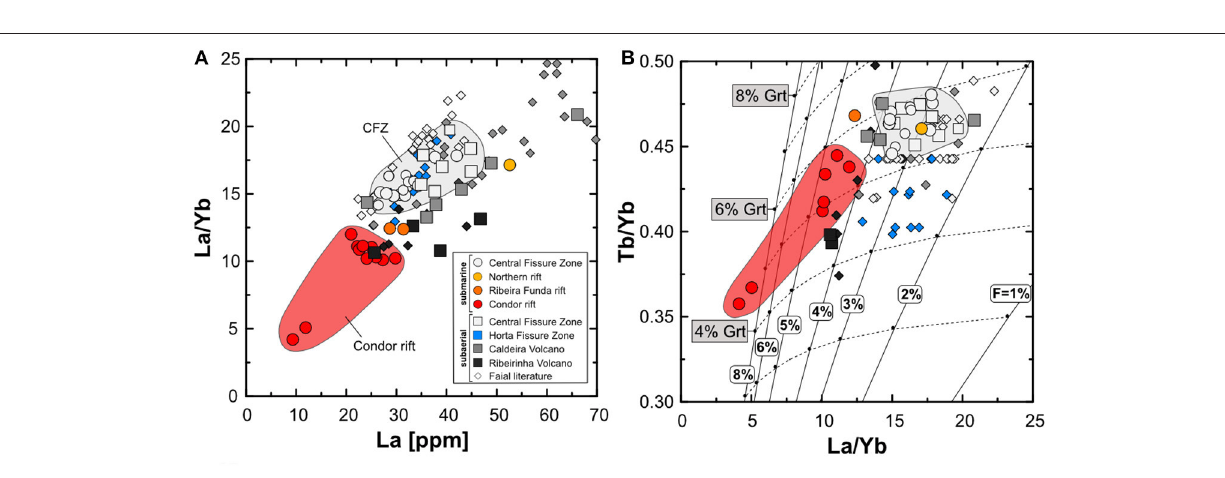
FIGURE 9 | La/Yb vs. (A) elemental concentration of La [ppm] and; (B) Fractional melting model modified from Bourdon et al. (2005) and Beier et al. (2013) for Faial lavas using a Tb/Yb vs. La/Yb space and a primitive mantle source from Sun and McDonough (1989) comprised of 55% olivine, 25% orthopyroxene and variable ratios of clinopyroxene and garnet as shown by gray boxes and dashed lines, respectively. White boxes and solid lines mark the degree of partial melting. Partition coefficients for olivine, orthopyroxene, and clinopyroxene were taken from those compiled in Halliday et al. (1995) and references therein, Adam and Green (2006) and Villemant et al. (1981), for garnet from Green et al. (2000). The distribution coefficients used for this model can be found in Supplementary Table 3. Data sources are the same as in Figure 4